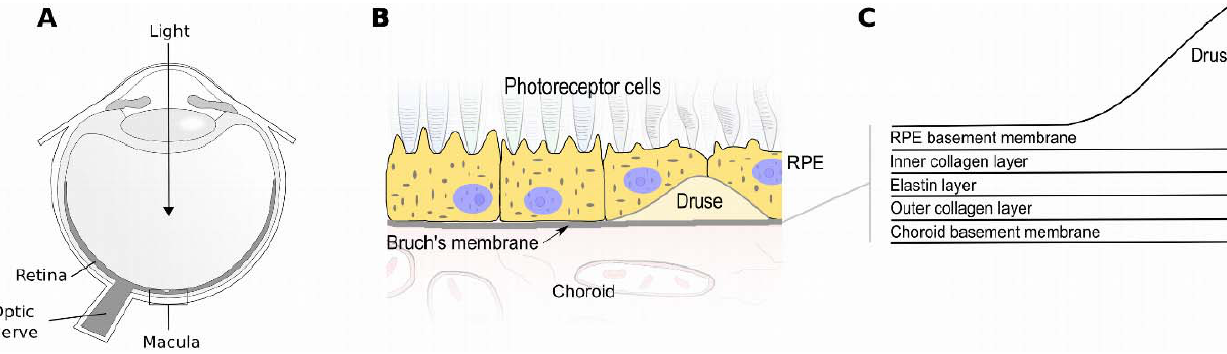
Figure 1. Anatomy of the human eye affected by age-related macula degeneration. ( A ) A cross section of the human eye highlights the macula; ( B ) In early AMD, extracellular deposits called drusen form within Bruch’s membrane underneath the retinal pigment epithelium (RPE); ( C ) Bruch’s membrane is composed of five layers: an elastin core is sandwiched between two collagenous layers and these are surrounded by basement